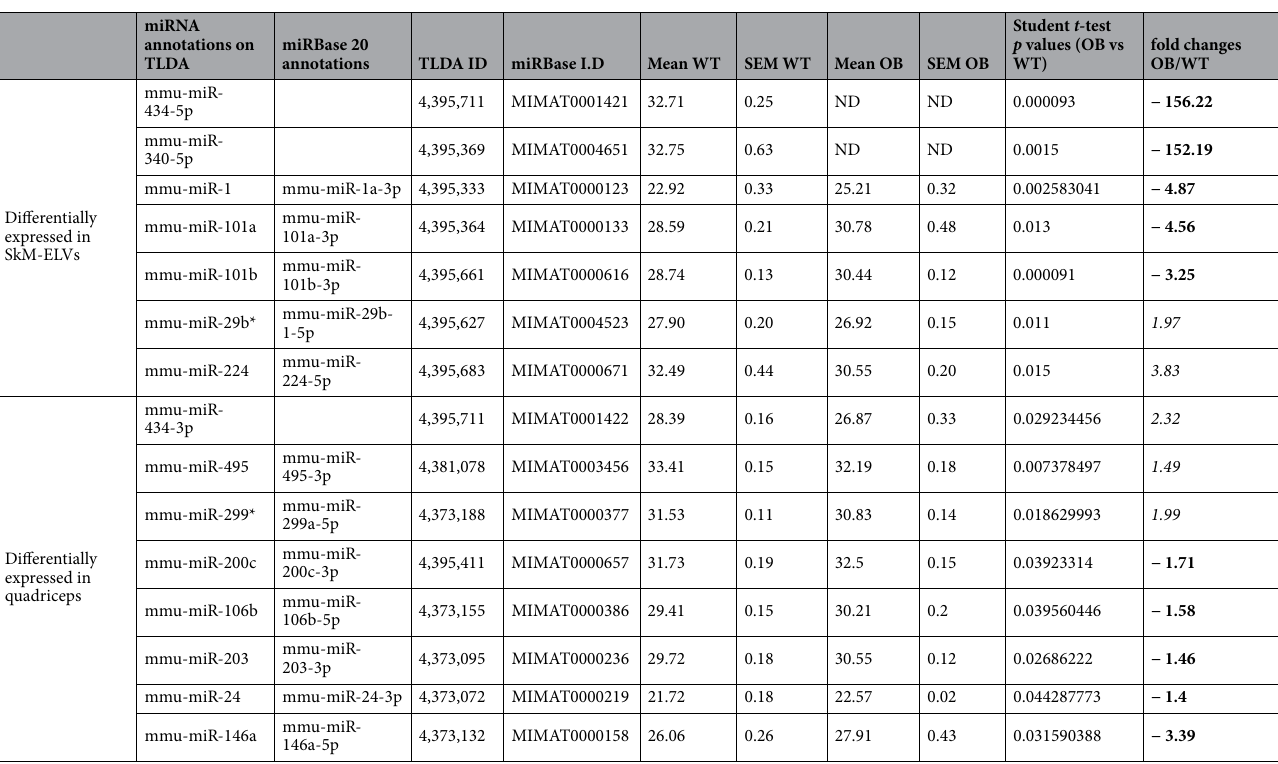
Table 1. miRNAs differentially enriched between WT-ELVs vs OB-ELVs (n = 4 animals per group) or between quadriceps muscle of OB vs WT (n = 3). Data are expressed as qRT-PCR C t values. The C t is defined as the number of cycles required for the fluorescent signal to cross the threshold ( i.e. ; exceeds background level). C t levels are inversely proportional to the amount of target nucleic acid in the sample ( i.e. ; the lower the Ct level the greater the amount of target nucleic acid in the sample). In italics: miRNAs increased in OB-ELVs vs WT-ELVs; in bold miRNAs decreased in OB-ELVs vs